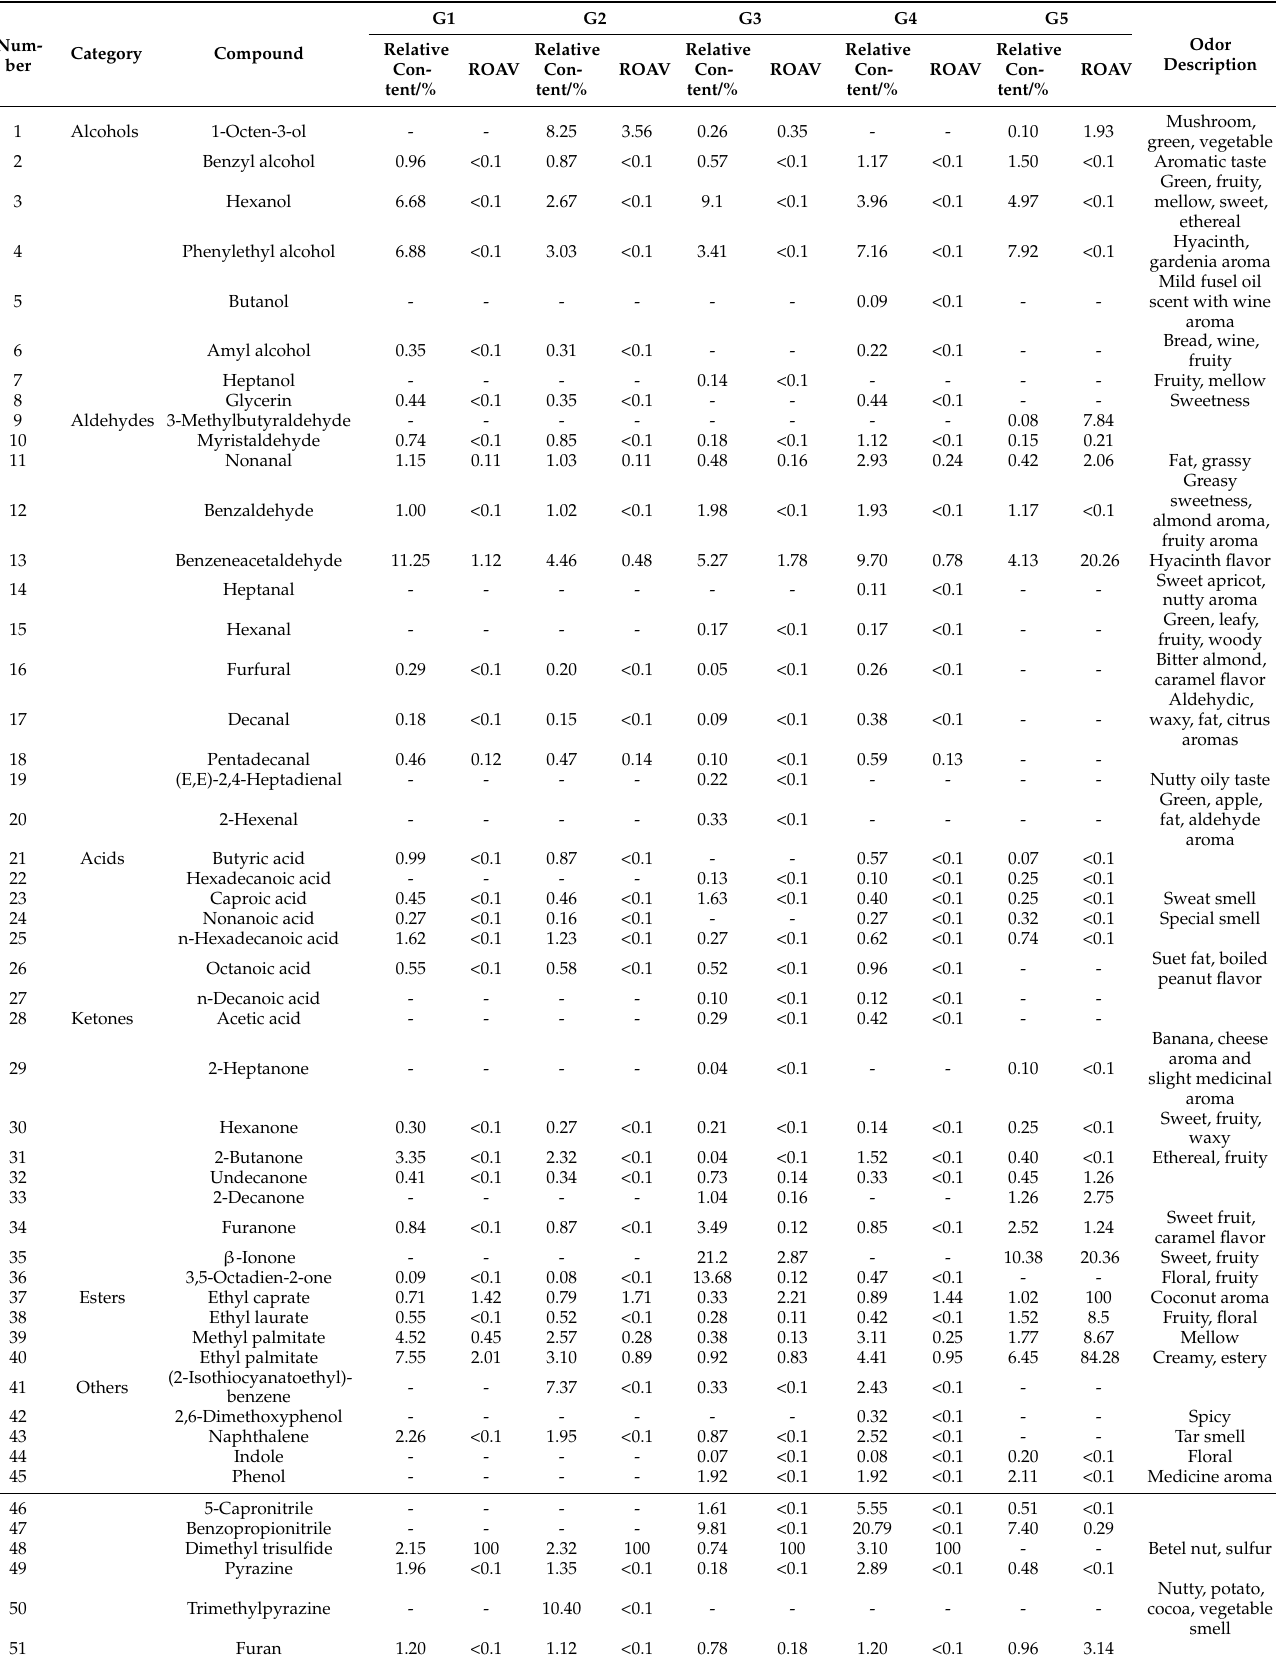
Table 3. Analysis of volatile flavor components in pickled BLS with different salt